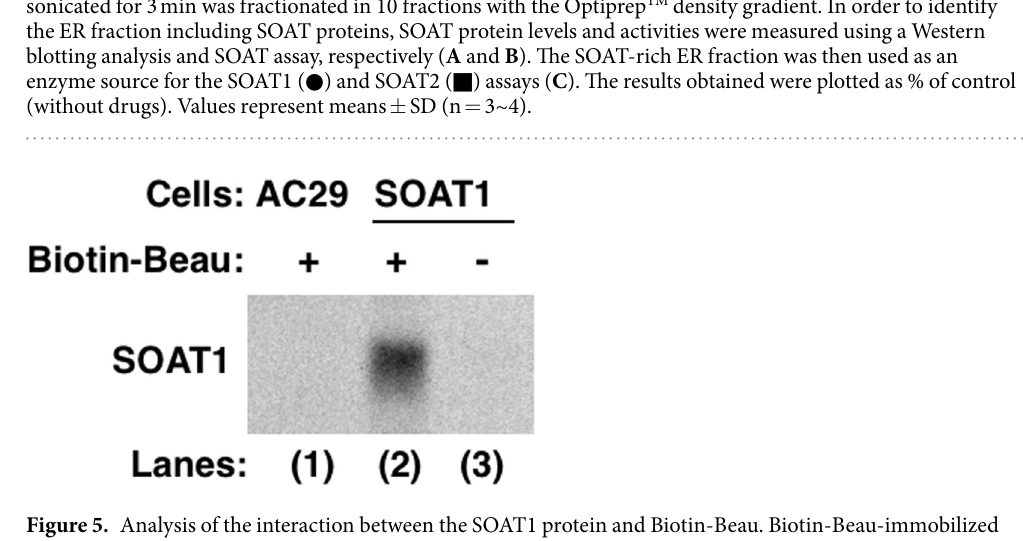
Figure 5. Analysis of the interaction between the SOAT1 protein and Biotin-Beau. Biotin-Beau-immobilized beads were used to analyze the interaction between beauveriolide and the SOAT1 protein. Bound proteins were analyzed using SDS-PAGE and Western